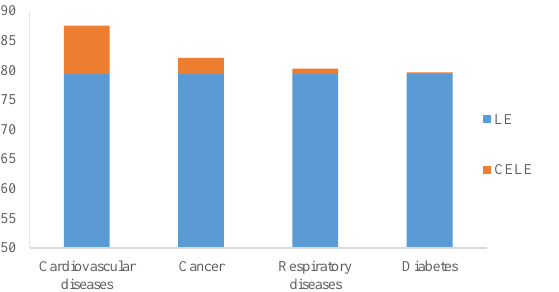
Figure 1. Life expectancy of Chinese residents after eliminating diseases’ deaths, 2019. LE: Life expectancy; CELE: Cause-eliminated life expectancy. When classified by age, after eliminating CVD deaths, the LE of different age groups increased significantly. Our comparison of different age groups showed that after removing cancer deaths, LE was reduced by 2.68 years for the 0-year-old group and by 0.51 years for the 85+ group. After the elimination of respiratory disease and diabetes as causes of death, LE increased by 0.88 and 0.24 years for the 0-year-old group and by 0.75 and 0.09 years for the 85+ group, respectively (Figure 2).